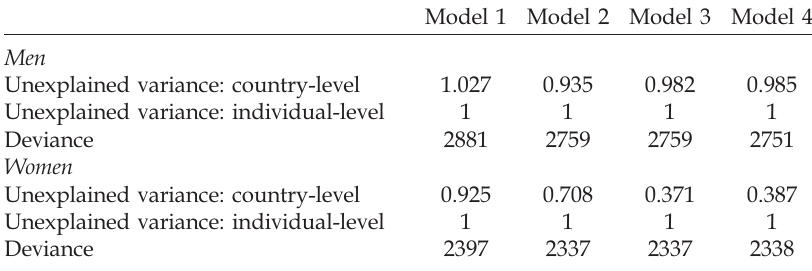
Table 2. Older persons’ workforce participation: model